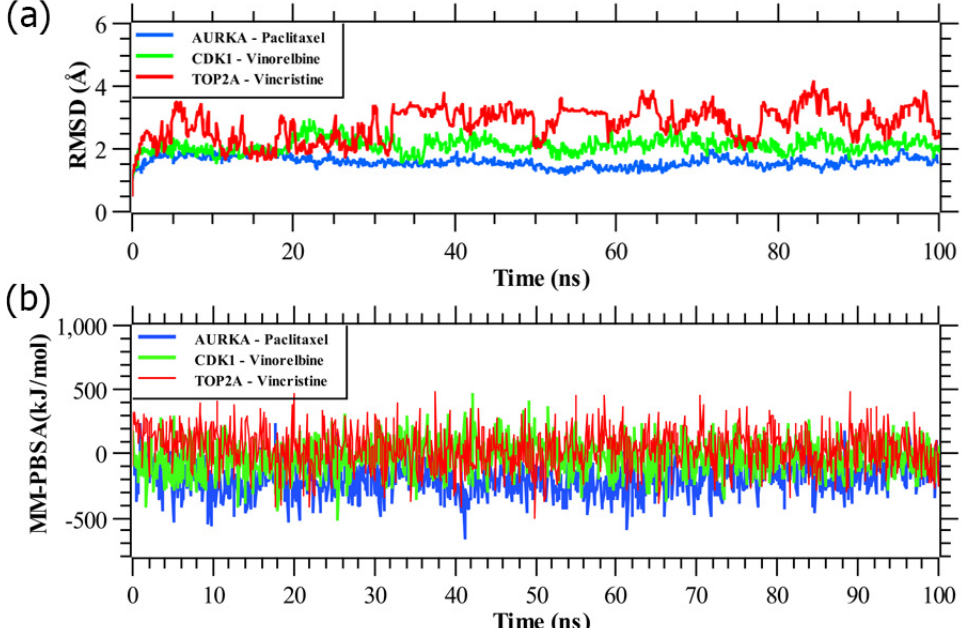
Figure 8. ( a ) Time evolution of root mean square deviations (RMSDs) of backbone atoms (C, C α , and N) for protein for each docked complex. ( b ) Binding free energy (in kJ mol − 1 ) of each snapshot was calculated by molecular mechanics Poisson–Boltzmann surface area (MM-PBSA) analysis, representing the change in binding stability of each complex during simulations; positive values indicate better binding. Complexes: blue AURKA, green CDK1, and red TOP2A.